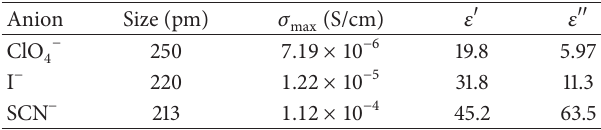
Table 1: Values of conductivity and dielectric parameters for , NaI, NaSCN) containing systems along with different salt (NaClO 4 the salt anion